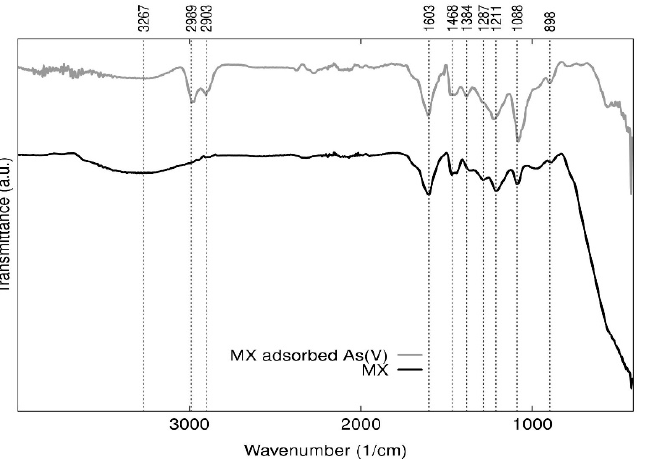
Figure 4. FTIR Spectra of Magnetic Xerogel Monoliths before and after arsenic (V) adsorption.